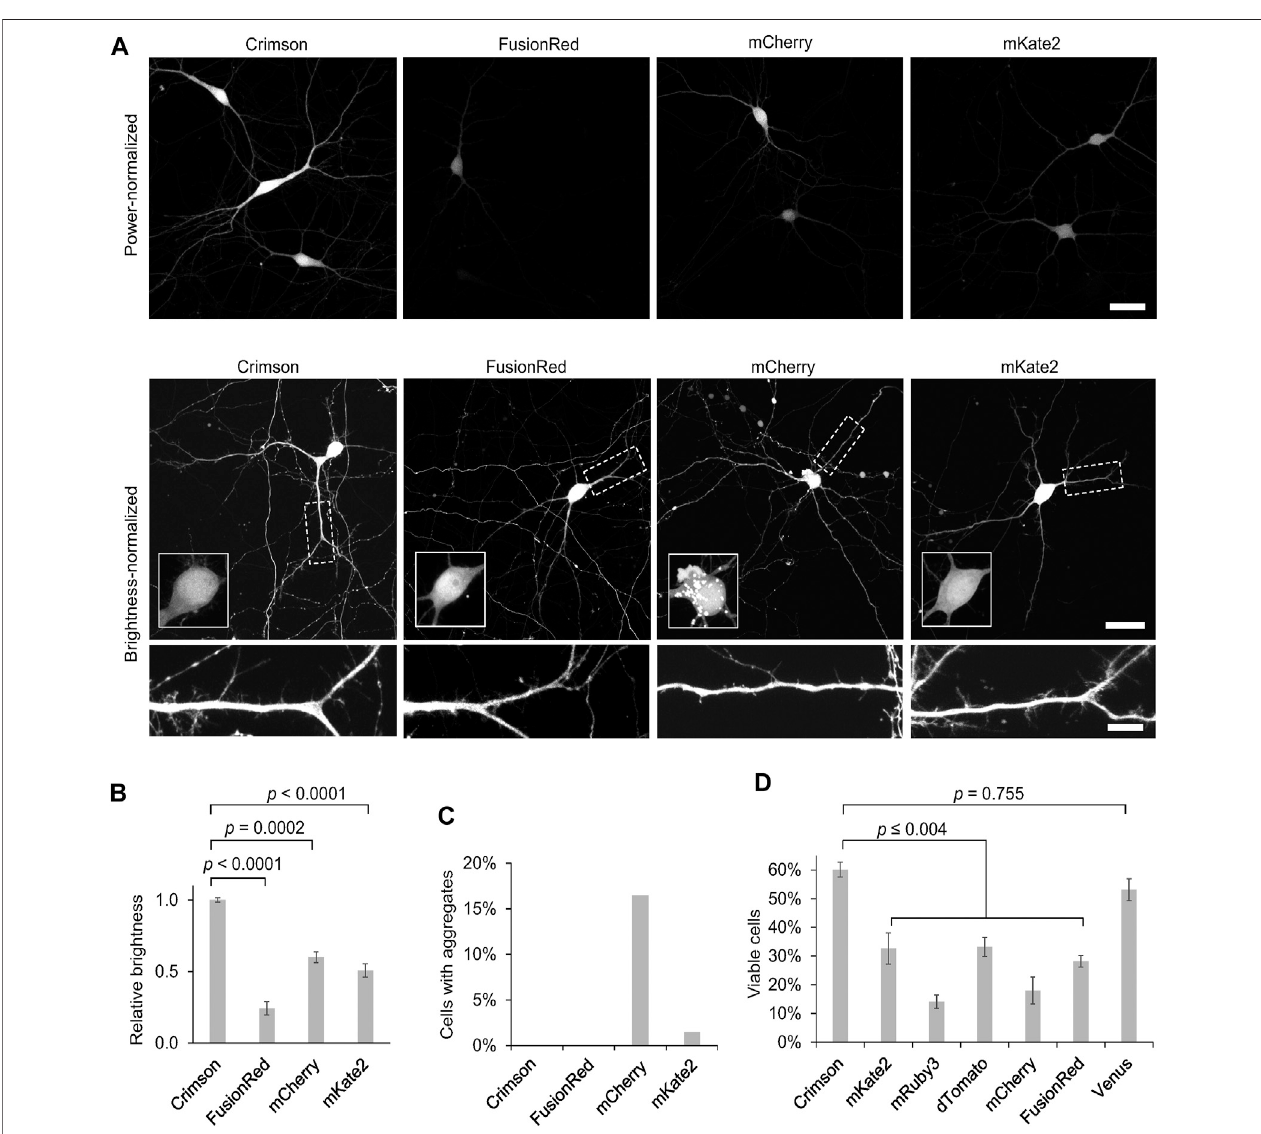
FIGURE3| CytosolicCrimsonisbrighterandlesscytotoxicthanotherRFPsinneurons. (A) ComparisonofRFPsinrathippocampalneuronsimagedwithconfocal microscopy3 dayspost-transfectionat12DIV.Top,representativeimagesoftransfectedneuronsacquiredanddisplayedwithidenticalsettingsareshown.Scalebar= 20 µm. Bottom, representative images with brightness adjusted to similar levels for display. Cell bodies are enlarged in the insets within the upper panels. Dendritic segmentsindicatedbythedashedrectangleareenlargedinthelowerpanels.Scalebar=5 µm. (B) Quanti fi cationofRFPbrightness3 dayspost-transfectionat12 DIV. Error bars = SEM (Standard Error of the Mean). Overall p < 0.0001 by one-factor ANOVA. (C) Quanti fi cation of the percentage of neurons with aggregates among total transfected neurons 3 days post-transfection at 12 DIV. (D) Quanti fi cation of the percentage of healthy neurons among total transfected neurons 9 days post- transfection at 18 DIV. Error bars = SEM. Overall p < 0.0001 by one-factor ANOVA.